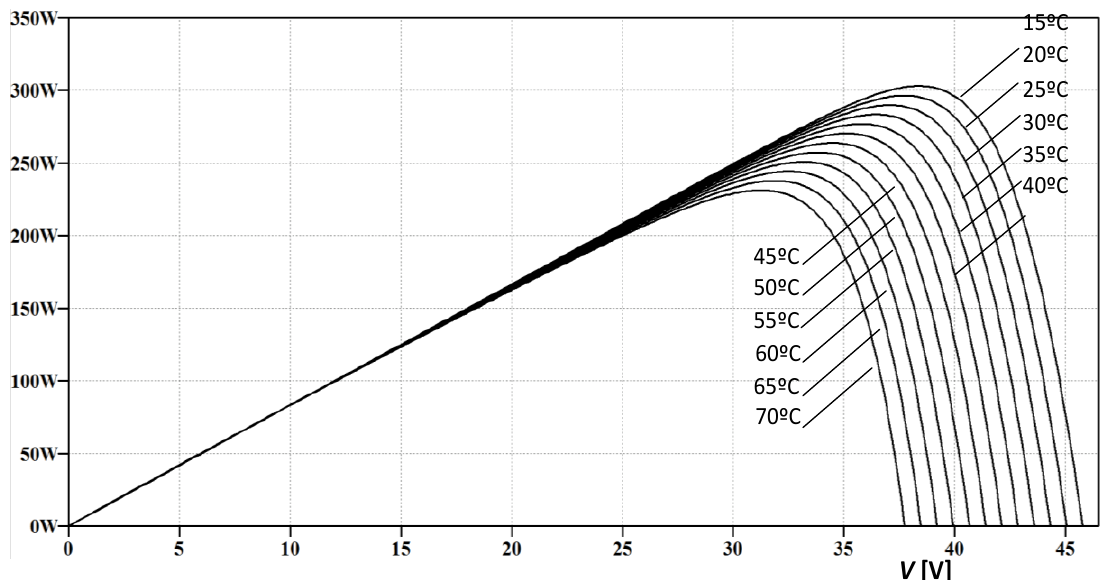
Figure 7. Power curves of panel MSP290AS-36.EU simulated with LTSpice calculation of the equivalent circuits for different temperature levels, from 15 °C to 70 °C, with 1000 W/m 2 irradiation level.